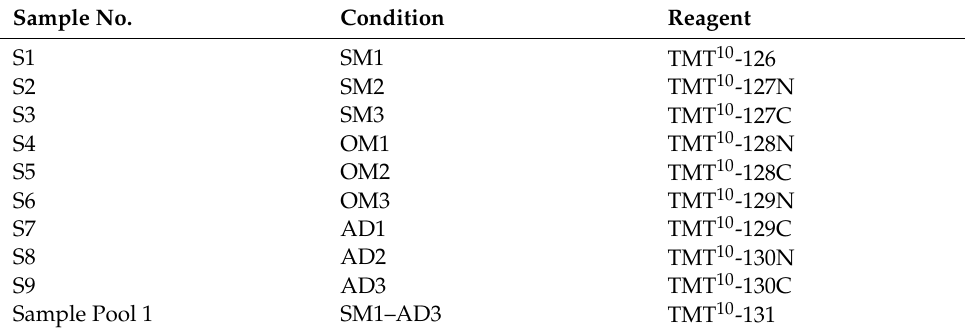
Table 1. TMT10 reagents added per